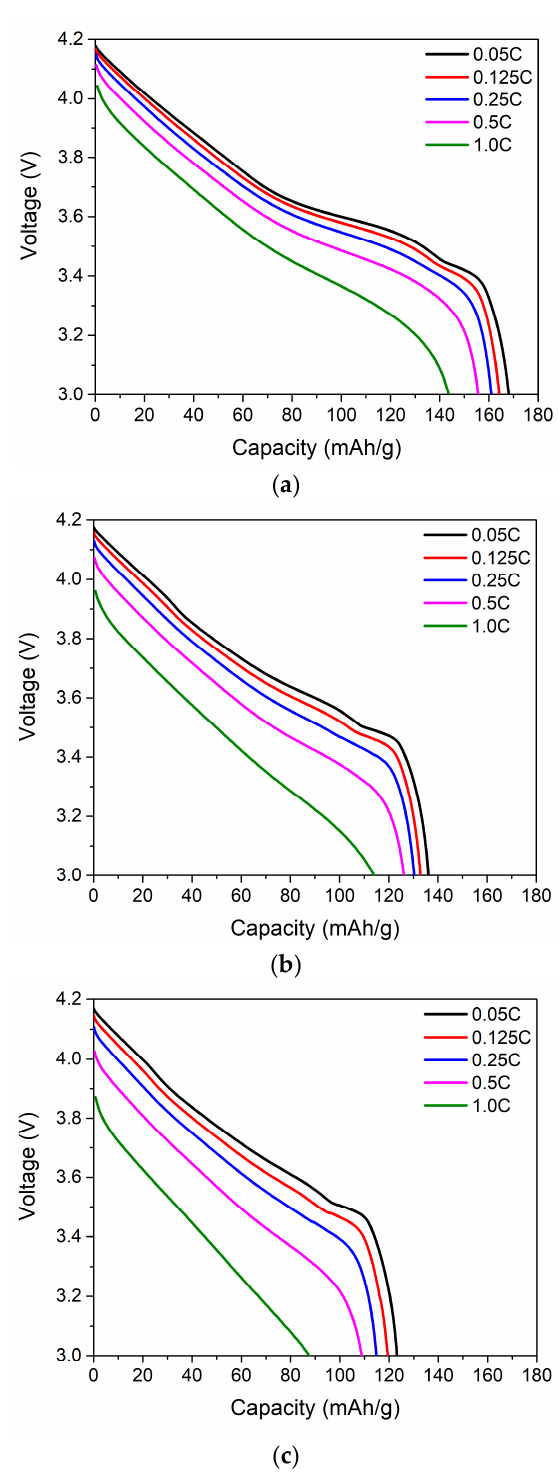
Figure 2. Experimental discharge curves of the lithium ‐ ion battery (LIB) cells with three different levels of the loss of cyclable lithium: ( a ) 0%; ( b ) 10%; and ( c ) 20%.